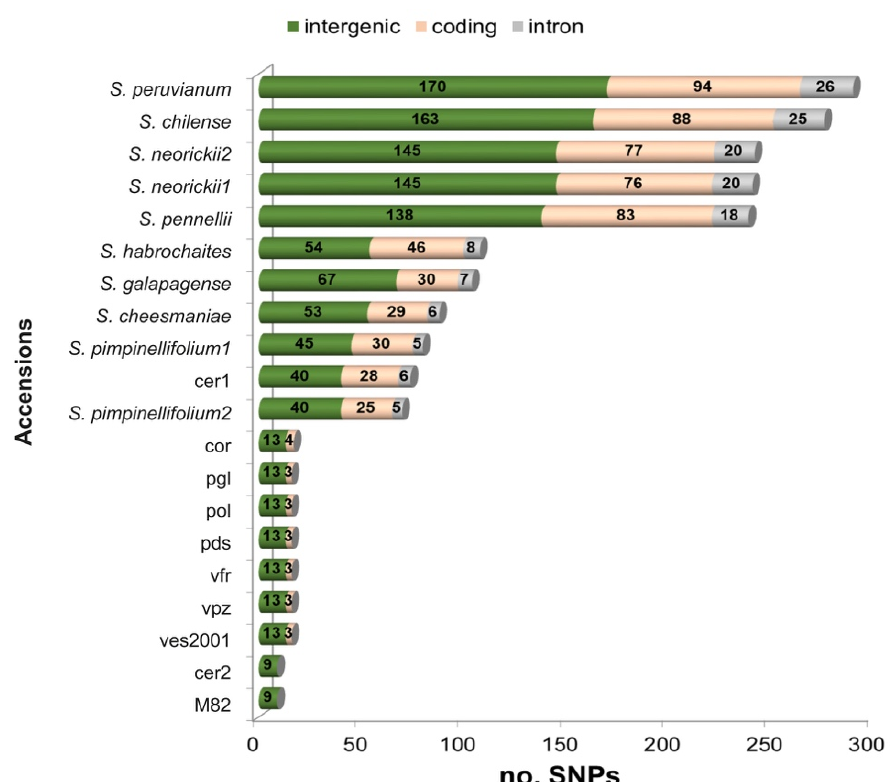
Figure 1. Stacked bar chart showing the distribution of single nucleotide polymorphisms (SNPs) that fall within coding sequences of genes, introns, and intergenic regions of the nine tomato plastomes sequenced in this work and in those of eleven species retrieved from GenBank. The plastome of IPA-6 (AM087200) was used as reference for SNP calling.